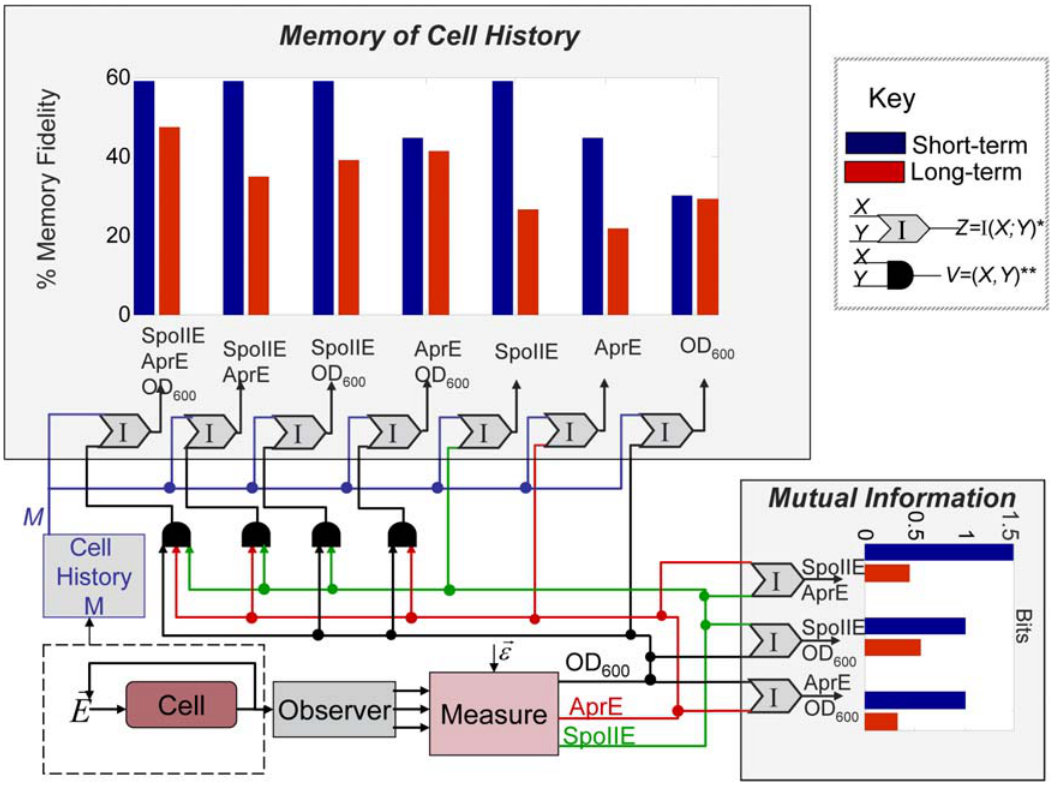
Figure 7. Estimates of cell-history memory and mutual information in B.subtilis. The upper left bar plot shows our estimate of long-term (blue bars) and short-term (first 11 hours, red bars) memory fidelity (% of the maximum recoverable information about cell history) exhibited in starvation medium SM by sporulation initiation (P spoIIE-gfp expression), degradative enzyme synthesis (P aprE-dsred expression), and growth dynamics (OD 600 ), and over all vector pairs of observable read-outs and the vector triple, with respect to the cell history space tested by our compendium. The lower right bar plot shows our estimate of the number of bits of mutual information shared by all pairs of short-term (red bars) and long-term (blue bars) observable signals in our memory data compendium. The surrounding flow diagram circuit illustrates the experimental and analytical scenario.